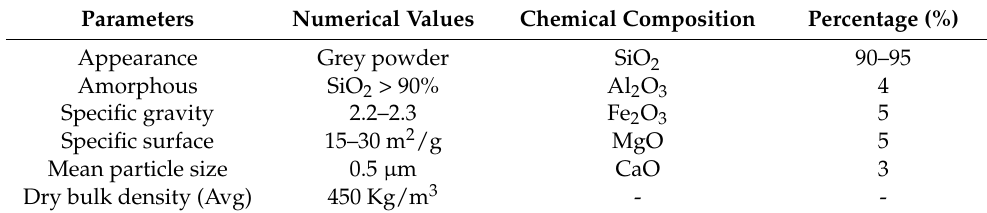
Table 2. Physical properties and chemical composition of silica fume.